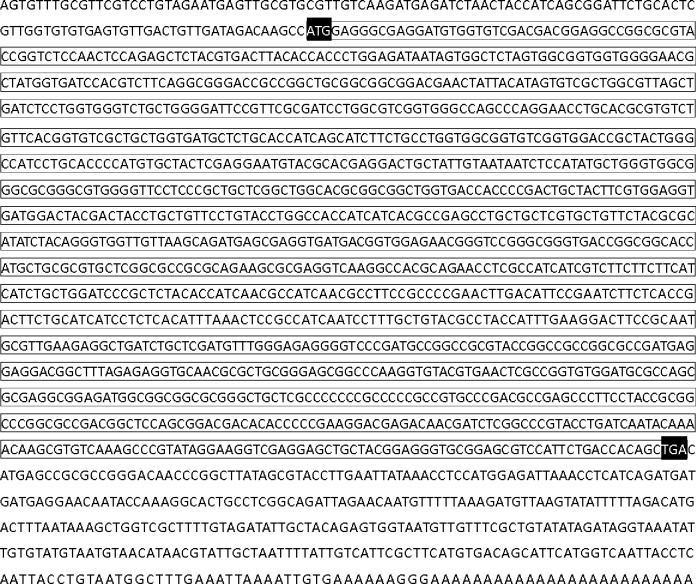
cDNA sequence of Plutella xylostella Adenosine Receptor.The line box area indicates the open reading frame (ORF), which encodes protein of 440 amino acids. The start codon (ATG) and the stop codon (TGA) are highlighted in black. The sequence was deposited in the GenBank (Assession No.KR258794).